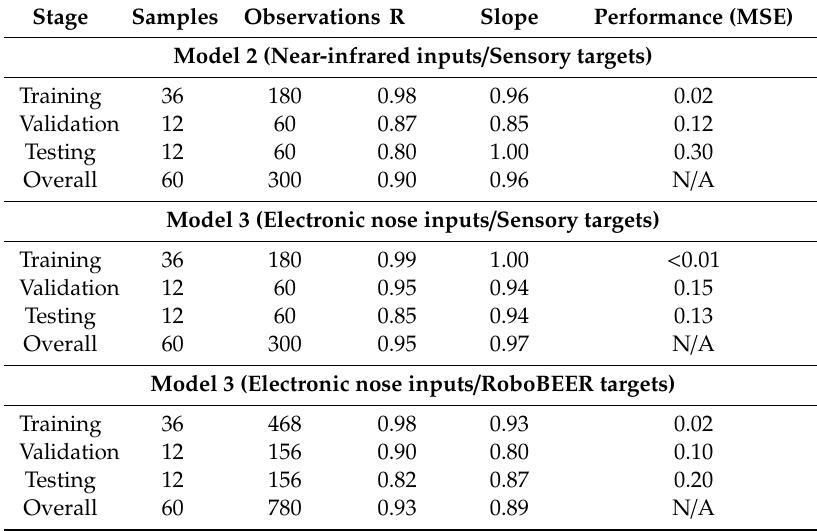
Table 5. Statistical data from the regression artificial neural network Models 2–5. Performance was based on means squared error (MSE). Abbreviations: R: correlation coe ffi